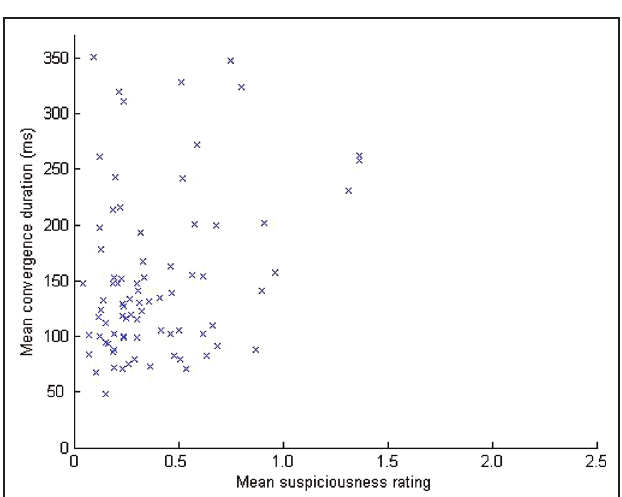
FIGURE 4 | The relationship between convergence period duration and ratings of perceived suspiciousness for trained CCTV